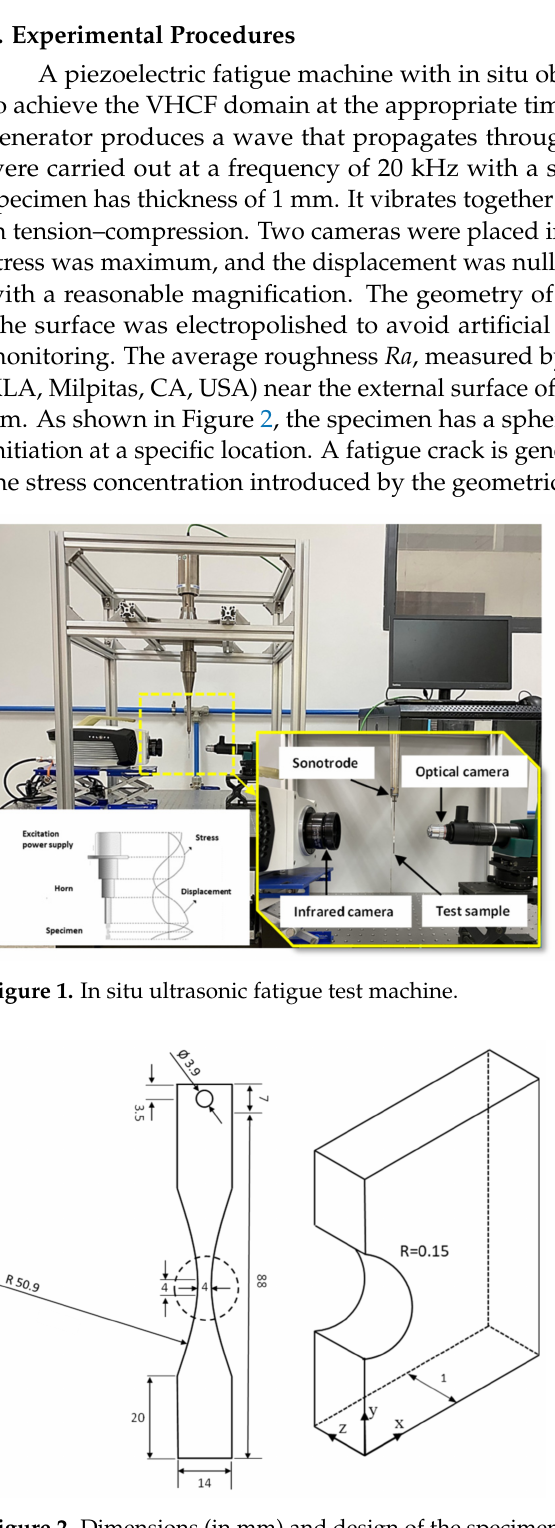
Figure 2. Dimensions (in mm) and design of the